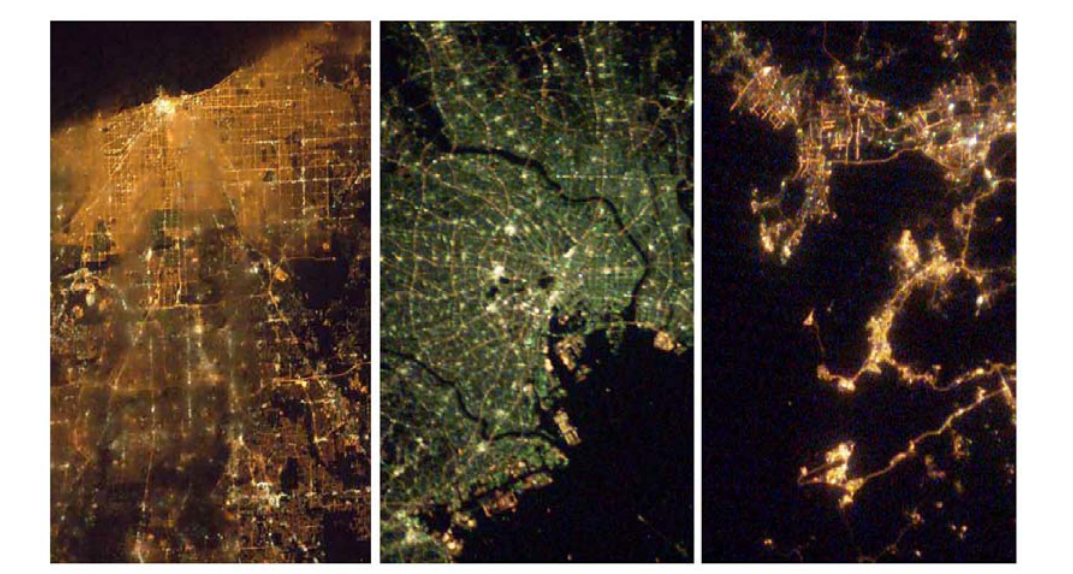
Figure 2. Color camera images of Chicago, Tokyo and Hong Kong acquired at sixty meter resolution from the International Space Station. Note the presence of optically thin clouds in the Chicago image, resulting in a blur of the street